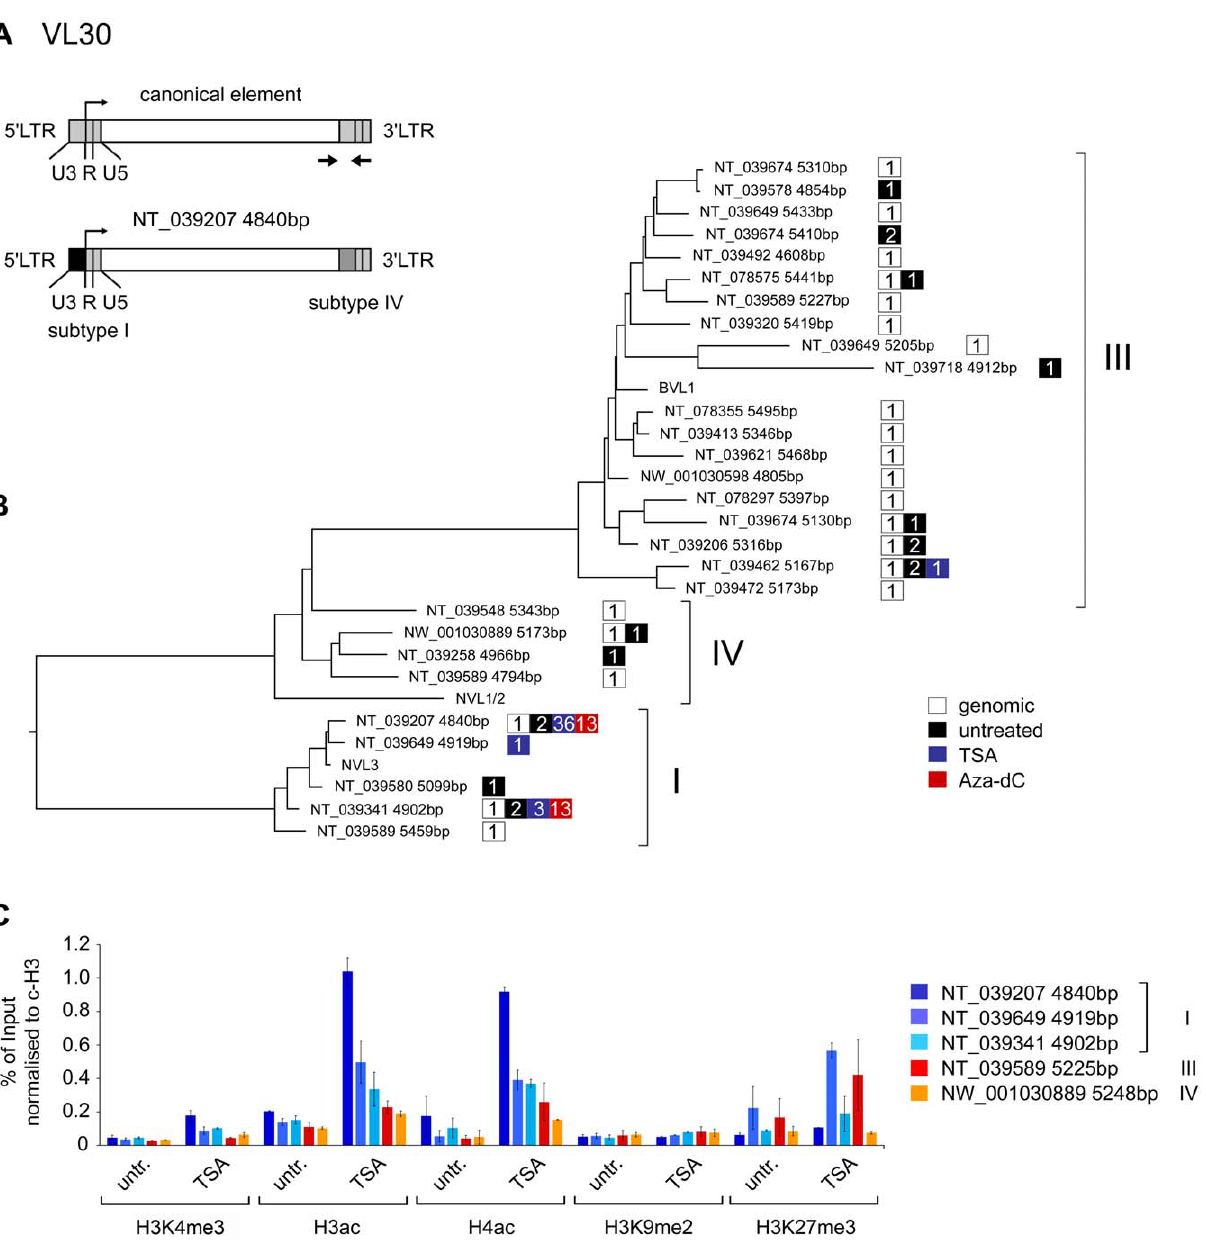
Figure 4. Characterisation of transcribed VL30 elements reveals preferential expression of defined VL30 elements upon stimulation. (A) Schematic view of a canonical VL30 retrotransposon. Two similar LTRs flank an internal region without functional open reading frame (upper part). Some elements have a hybrid structure and are flanked by LTRs belonging to different subtypes (lower part). Primers used to amplify fragments of genomic and transcribed VL30 elementsfrom untreated, TSAandAza-dC treated fibroblastsare indicated as blackarrows. (B) To characterise thegenomic VL30 elements identified as bona fide transcriptional sources, their 5 9 LTR sequences were aligned (using the Megalign program with the following settings: Clustal W, gap penalty 15, gap length penalty 6.66, delay divergent seqs 30%, DNA transition weight 0.5, DNA weight matrix IUB) and a phylogenetic tree was generated. TheLTR sequences fall intothree clades. The affiliation toone of the clades is determined bythe structure of the highly polymorphic U3 region. While many VL30 elements identified in untreated fibroblasts are associated with a subtype III U3 region, TSA and Aza-dC treatment leads to preferential expression of elements with a type I U3 region. Coloured squares indicate the source, where the VL30 element has been isolated from (white, genomic DNA; black, untreated fibroblasts; blue, TSA treated fibroblasts (166nM; 24h); red, Aza-dC treated fibroblasts (1 m M; 24h; recover 24h), numbers indicate the transcriptional activity of the respective elements ( i.e. number of clones mapping best to this genomic locus). NVL3, BVL1, NVL1/2 serve as reference elementswithknownU3 regions andare described elsewhere [85–87]. (C) Tosurveythe chromatinsignature of individual VL30elements,ChIPexperiments in logarithmically growing fibroblasts untreated or treated for 12h with TSA (166nM) were performed. H3K4me3, H3ac and H4ac antibodies were used to survey the enrichment of active histone marks, H3K9me2 and K3K27me3 antibodies to measure levels of repressive marks. Values were normalised to local histone occupancy as determined with ChIP experiments using the c-H3 antibody and are given as percentage of Input. Primers targeting the upstream regions and 5 9 LTRs of individual elements allowed determining histone modification levels of five specific VL30 elements. NT_039207 4840bp is an element highly expressed upon TSAtreatment. NT_039649 4919bp and NT_039341 4902bp are two additional elements found expressed in TSA treated fibroblasts. Those three elements are associated with a U3 subtype I LTR region. NT_039589 5224bp and NW_001030889 5248bp are equipped with subtype III and IV U3 regions, respectively. N=2; 6 SD.